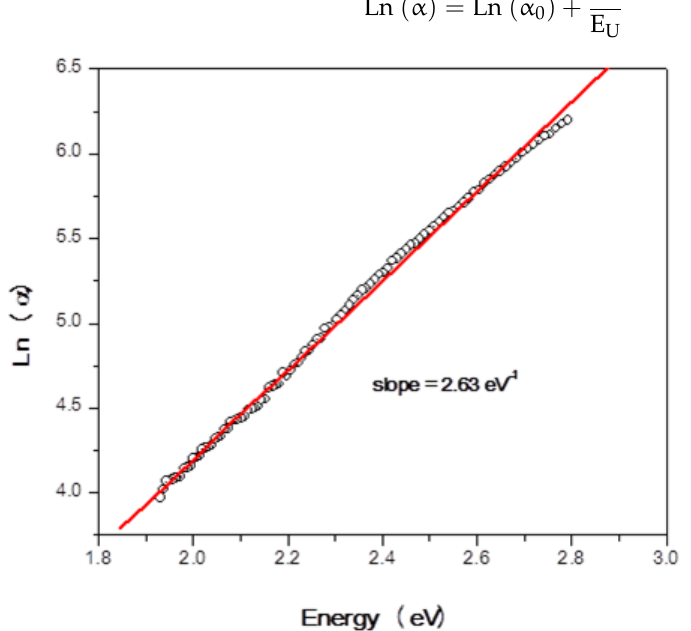
Figure 6. Variation of Ln ( α ) as a function of the photon energy in the case of doped PANI. (o)